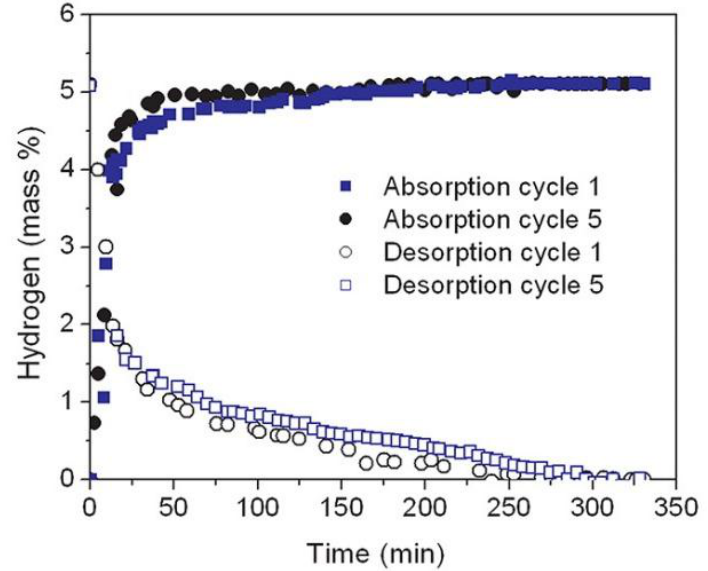
Figure 4. Kinetics of hydrogen desorption at 0.01 MPa and absorption under 4 MPa hydrogen pressure at 350 °C for NaBH 4 @Ni [38]. Reprinted with permission from [38], copyright 2012 The American Chemical